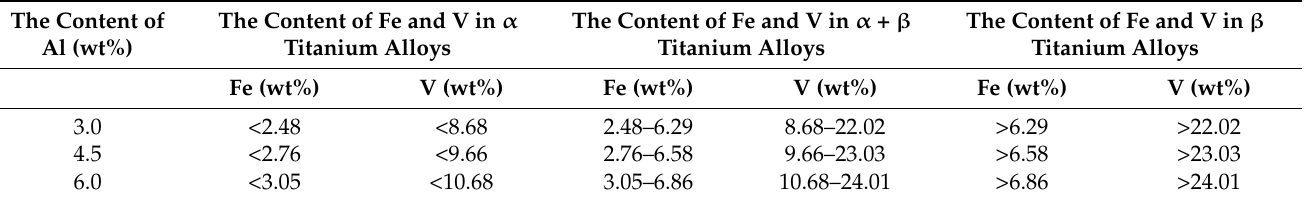
Figure 12. The calculated pseudo-binary section of V: Fe = 3.5:1 and 6.0 wt% Al. Table 5. The critical content of the element Fe and V in different types of titanium alloys with different Al content.